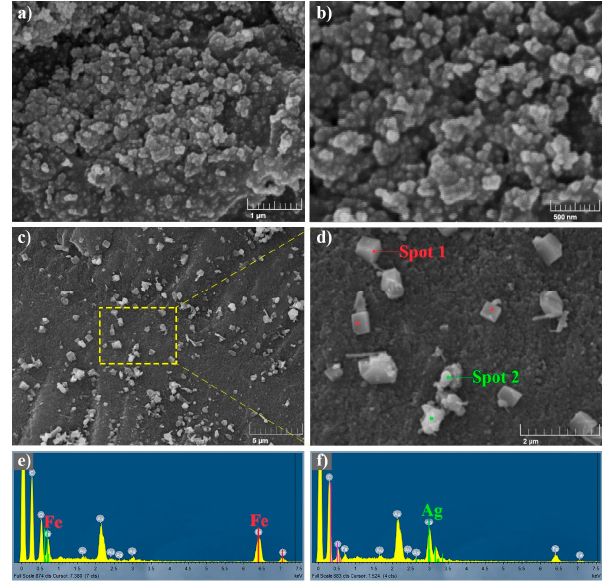
Figure 5. SEM images of CA ( a , b ) and Ag–Fe 2 O 3 @CA ( c , d ), and SEM-EDX spectra of Ag–Fe 2 O 3 @CA ( e , f ). Figure 6a,b are the bright field illumination of Ag–Fe 2 O 3 @CA. The major black particles can be assigned to Ag or Fe 2 O 3 according to the morphology identification in Figure 5.